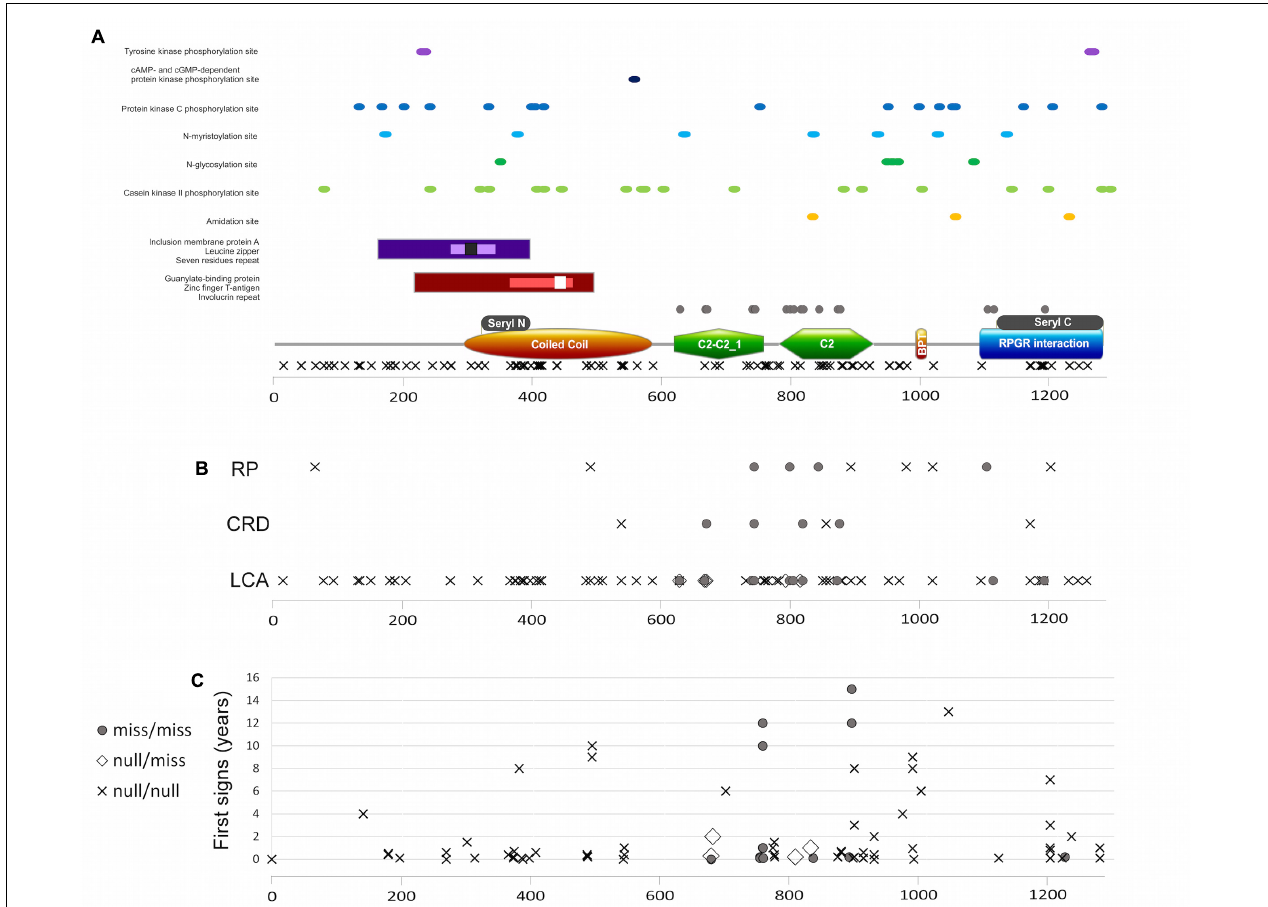
FIGURE 6 | (A) RPGRIP1 protein structure including protein domains and functional sites and mutation distribution. Major protein domains ( A bottom): orange rectangle represents the coiled coil domain, green polygon represents the C2-C2_1 and C2 domains, brown ellipse represents the bipartite nuclear localization domain, and blue rectangle represents the RPGR-interacting domain. Gray rectangles above the major domains represent the seryl tRNA synthetase N terminal and C terminal domains, respectively. Additional domains and areas: guanylate-binding protein marked with maroon rectangle, zinc-finger T-antigen with pink rectangle, involucrin repeat with white square, inclusion membrane protein A with purple rectangle, leucine zipper with lavender rectangle, and seven residues repeat with black square. Important sites marked with dots in different colors, as mentioned in the figure. Location of missense mutations is marked with gray circles above the major domains, and null mutations are marked with X below the major domains. (B) A plot of location of different mutation types along the protein and the clinical diagnosis of those patients. Gray circles represent the biallelic missense mutations, X represents the biallelic null mutations, and white rectangle represents the compound heterozygous condition with one missense and one null mutation. Frameshift or non-sense mutations that will lead to creation of prematurely truncated protein and are expected to abolish RPGRIP1 function are considered as null mutations. (C) A plot of appearance of first signs (as reported by the patient, in years) and location of the different mutation types along the